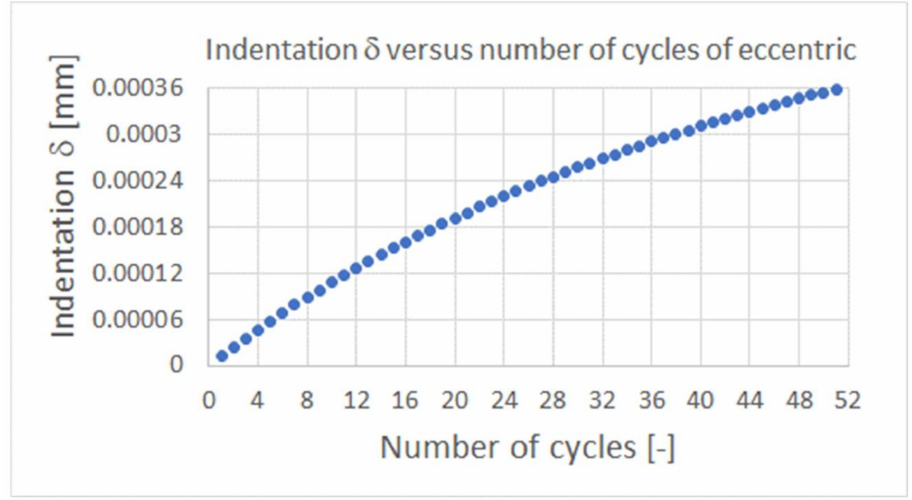
Figure 18. The indentation δ average values as a function of number of cycles of eccentric